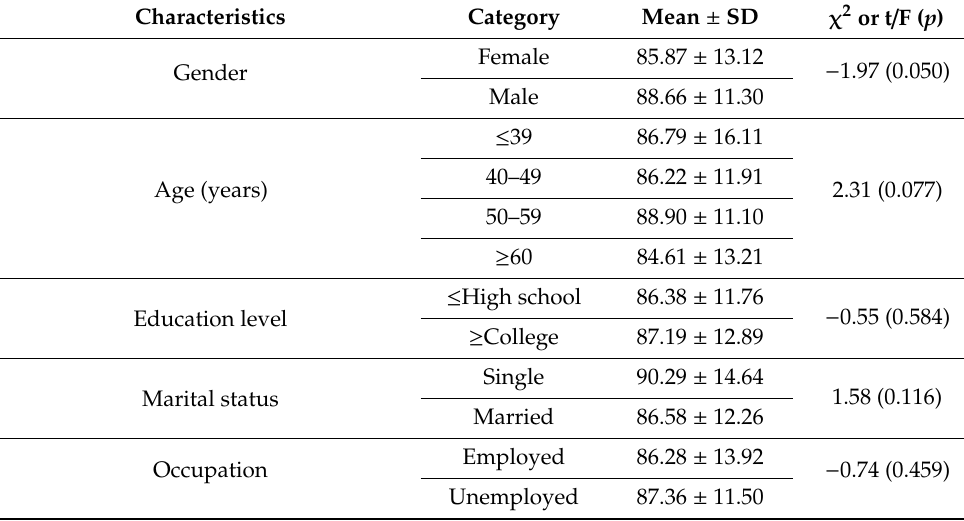
Table 5. Di ff erences in satisfaction with care services according to demographics and facility care-related characteristics, N =